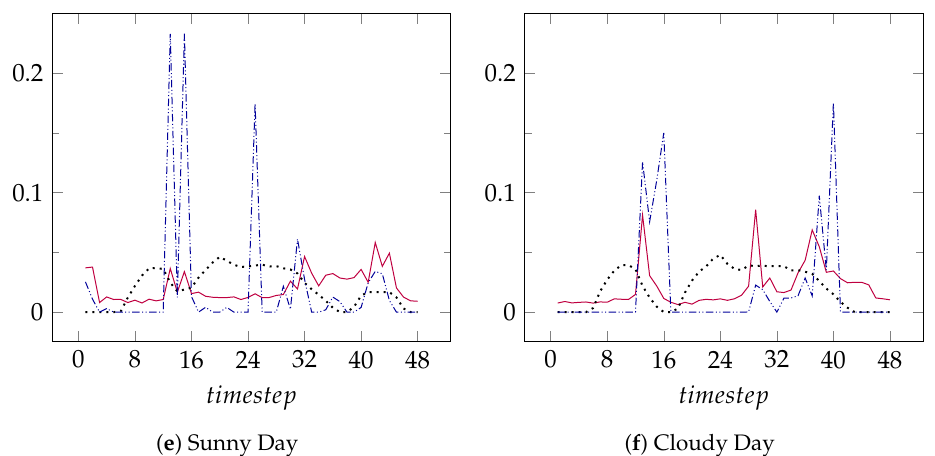
Figure 5. Non-dimensional energy demand profiles. Effect of weekday (( a ) vs. ( b )), season (( c ) vs. ( d )), and weather (( e ) vs. ( f )) on time and intensity distributions for a single-family